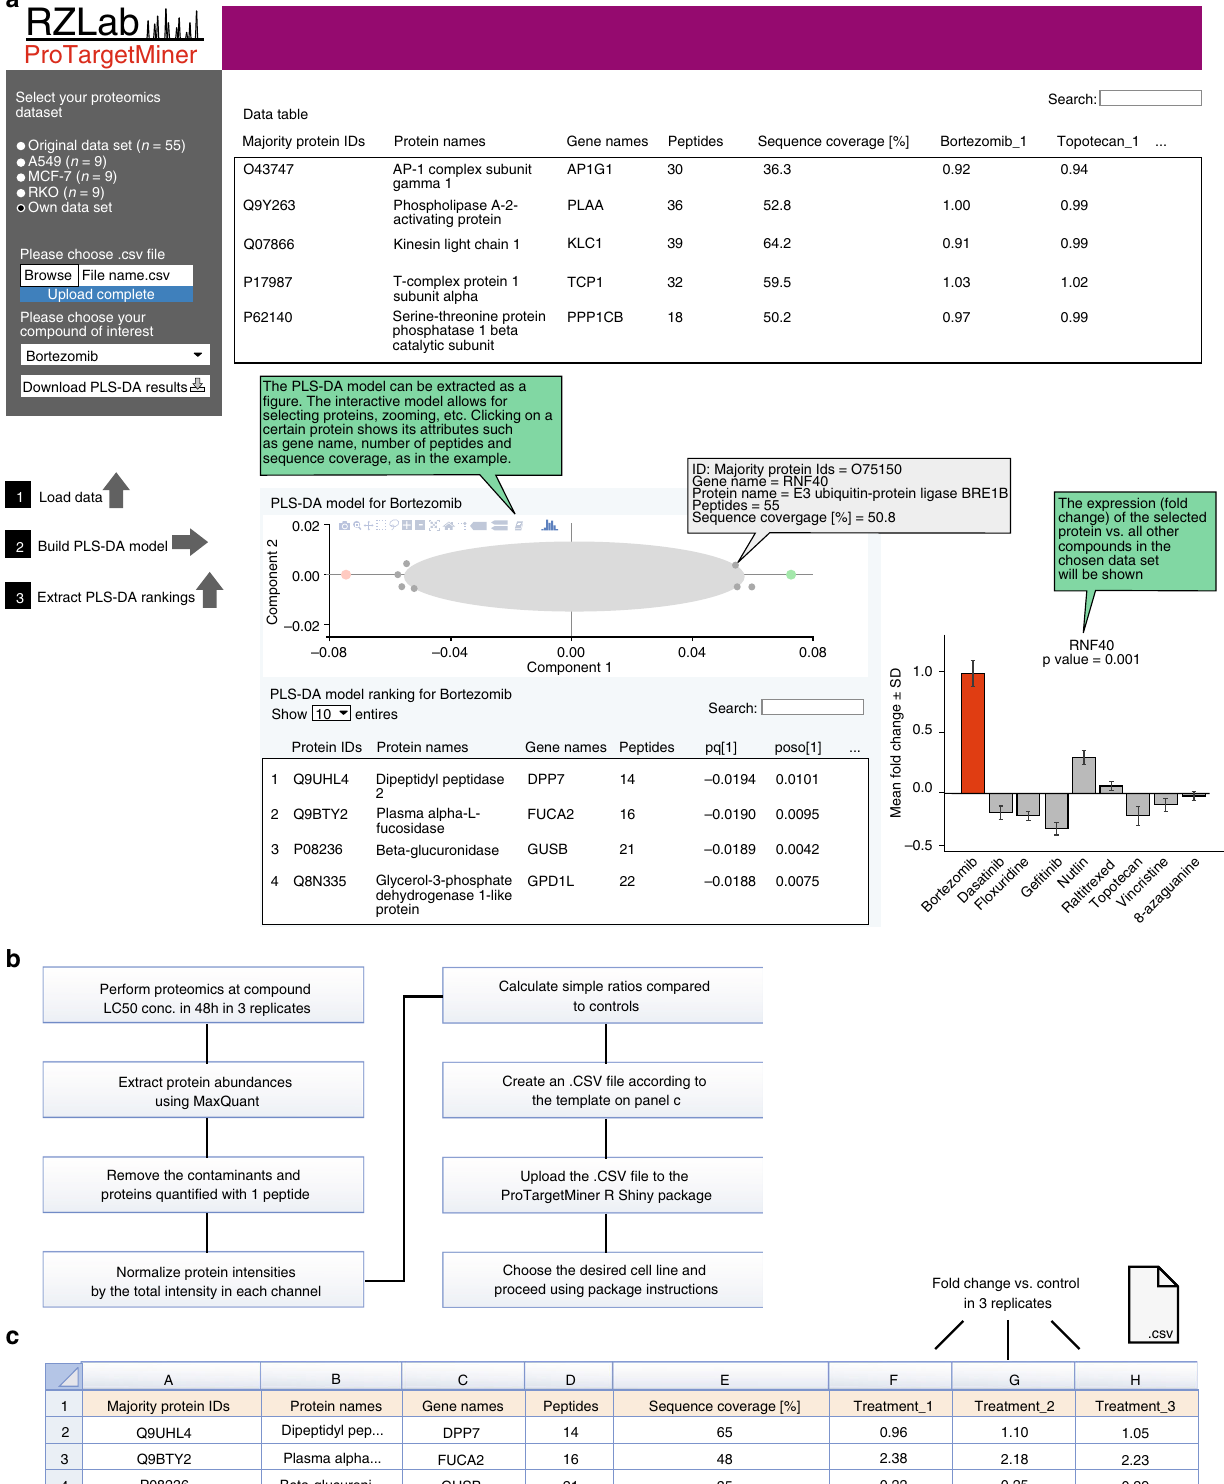
PLS-DA model can be extracted as a figure. The interactive model allows for selecting proteins, zooming, etc. Clicking on a certain protein shows its attributes such as gene name, number of peptides and sequence coverage, as in the example.